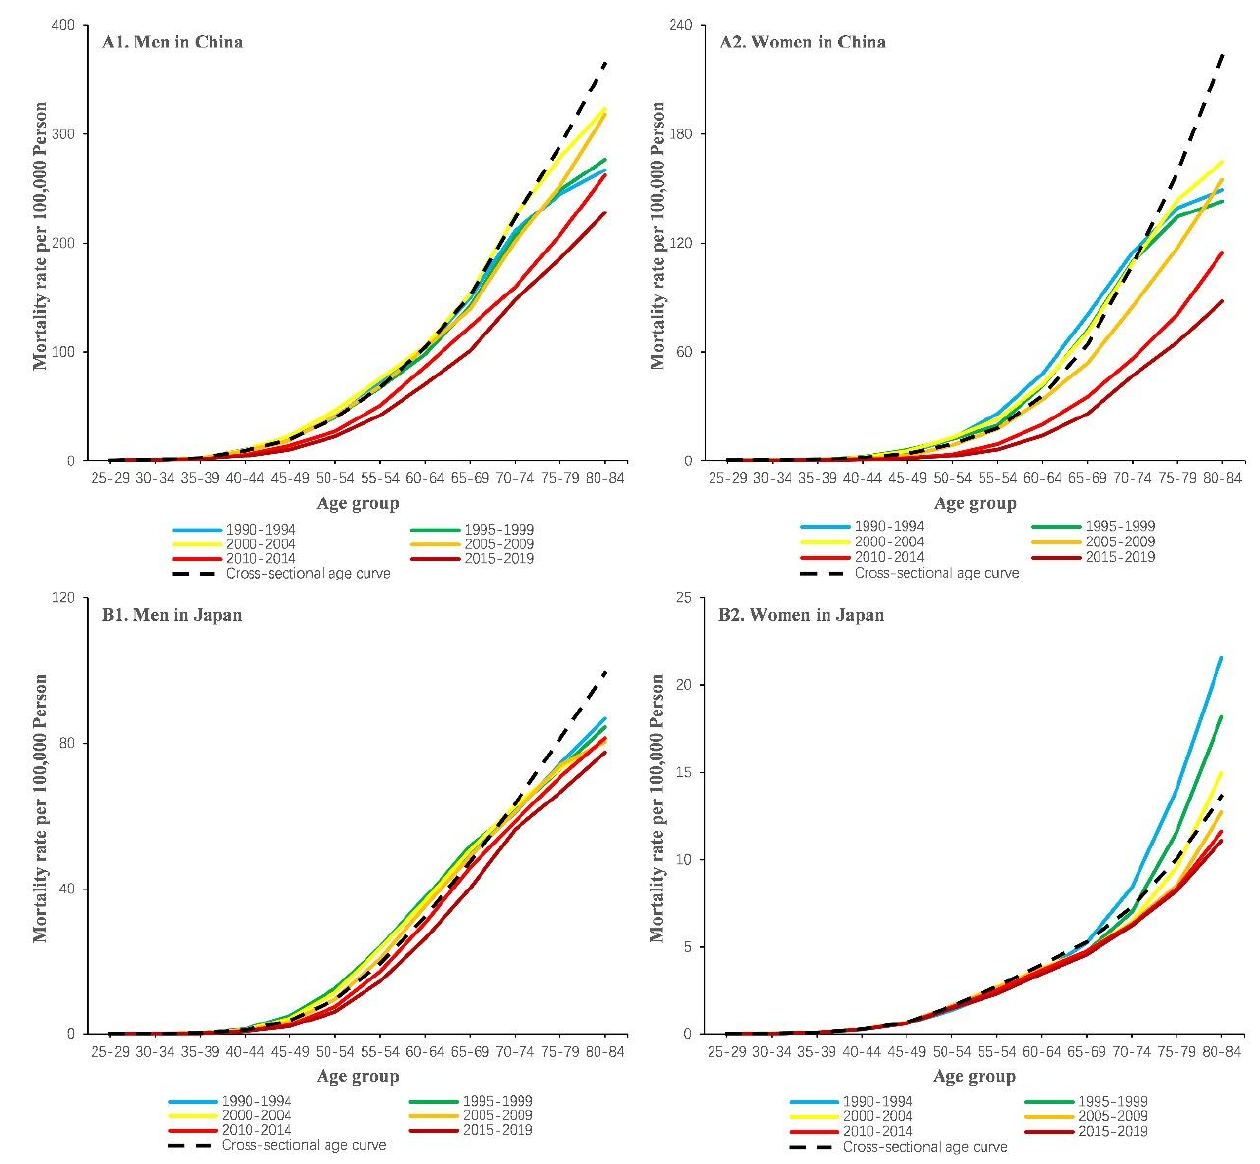
Figure 2. Age-specific mortality rates of esophageal cancer by period and sex in China ( A1 , A2 ) and Japan ( B1 , B2 ), 1990 to 2019. The study period was organized into 5-year periods, namely, 1990–1994 (median, 1992), 1995–1999 (median, 1995), 2000–2004 (median, 2002), 2005–2009 (median, 2007), 2010–2014 (median, 2012), and 2015–2019 (median, 2017). Cross-sectional age curves present the expected age-specific rates in the reference period, i.e., 2000 to 2004, after adjusting for cohort effects ( p < 0.01 for all).